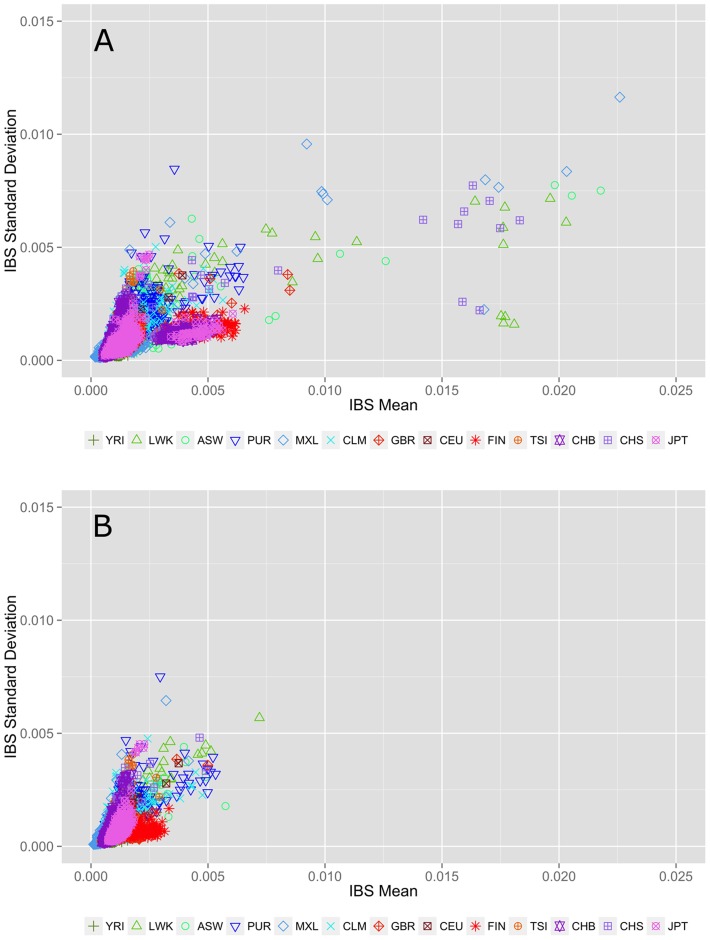

Within population identity-by-state (IBS) estimations A) before and B) after removing individuals with cryptic relatedness.The x-axis represents the IBS mean for low frequency variants averaged over 22 autosomal chromosomes. The y-axis corresponds to the standard deviation of IBS scores across 22 autosomal chromosomes. The colors and point types correspond to each population; color schemes correspond to general ancestry groups as defined for Figure 1. Each point represents a population pairwise IBS calculation (i.e. YRI-YRI, not YRI-CEU). Identifying and excluding related individuals removes the outliers seen in the top plot.